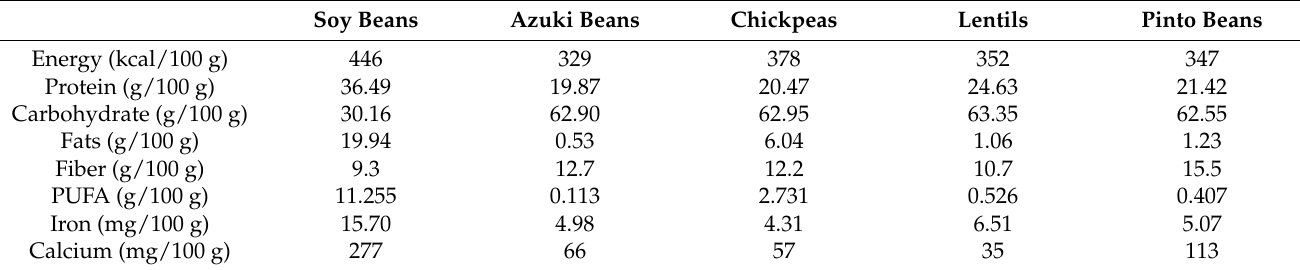
Table 1. Primary components of soybean and legumes.